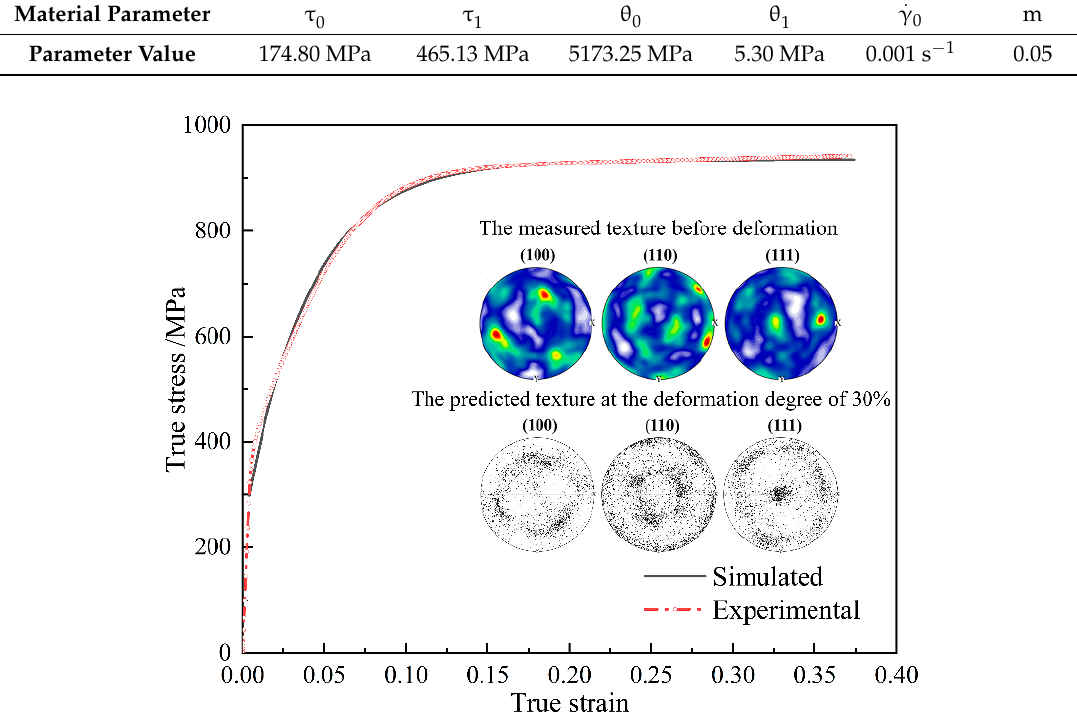
Figure 1. The simulated stress-strain curve and texture at the deformation degree of 30% based on the 1000 discrete orientations and the corresponding experimental result s .